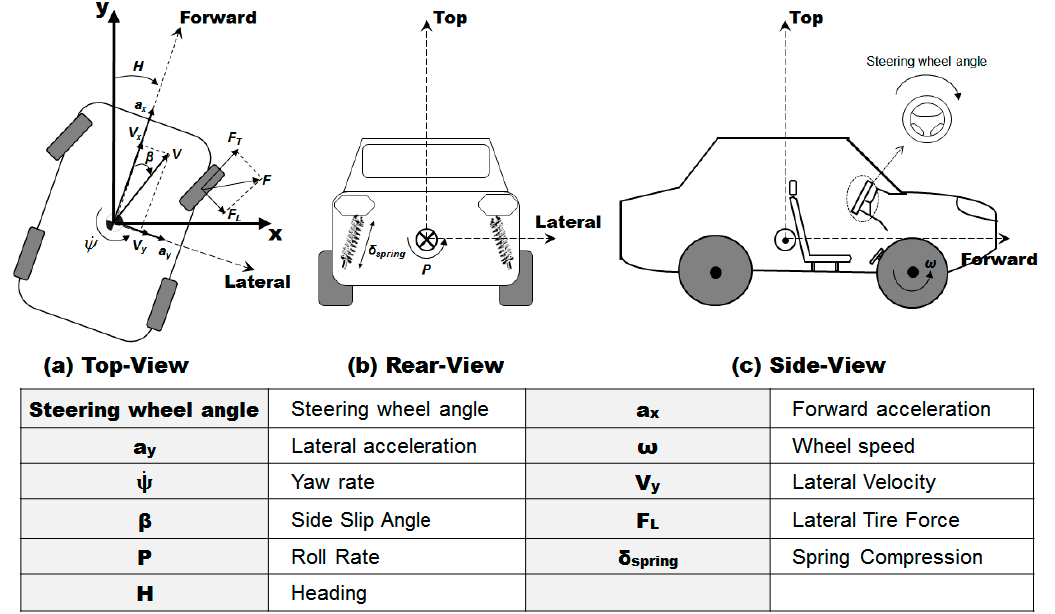
Figure 2. Vehicle states measured by on-board sensors and estimated by ANN models.